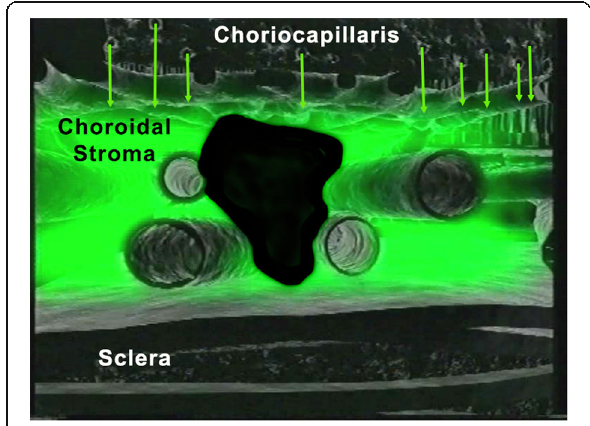
Fig. 7 Indocyanine green angiography (ICGA), Cartoon of type 2 pattern found in stromal choroiditis, featuring the presence of a focus in black